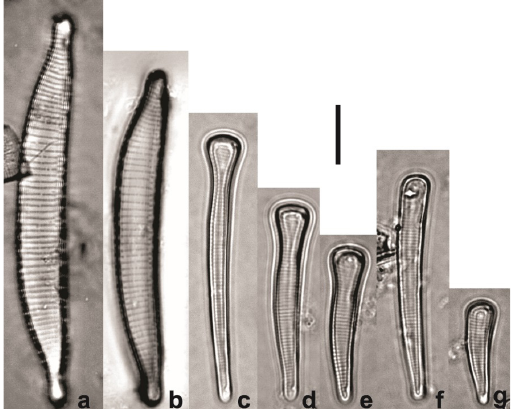
Figure 4a-g. General view of Actinella spp. valves under LM. 4a-b. A. pseudohantzschia . 4c-e. A. peronioides . 4f-g. A. aff. subperonioides (scale bar: 10